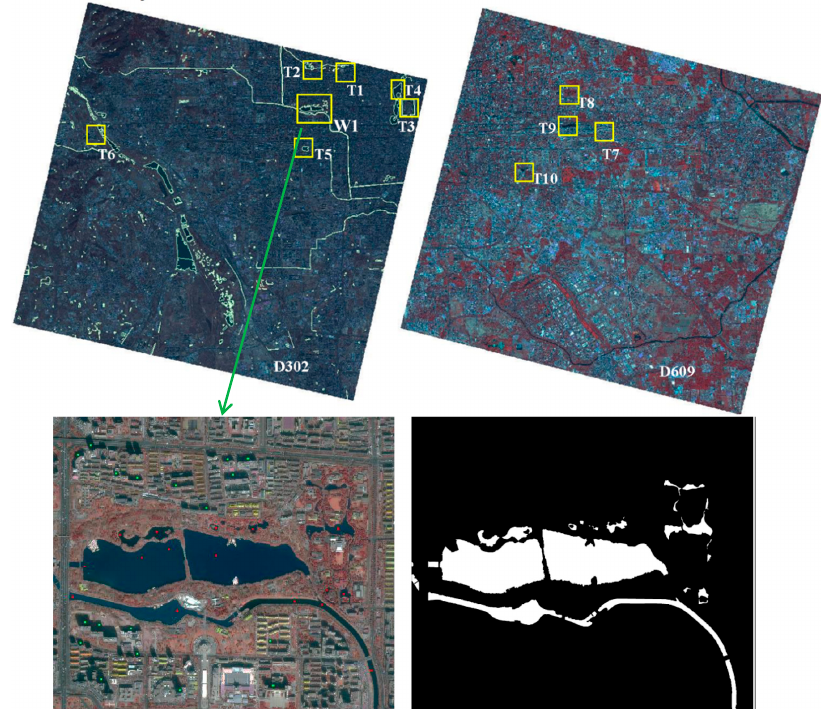
Figure 1. The two upper images are pan-sharpened GaoFen-2 images (namely D302 and D609) and the related training and test data in our experiment. W1 refers to the training subset. T1 to T10 refer to subsets for the test, and the size of each test data is 1500×1500 pixels. Water areas enclosed by light green lines in D302 indicate manually interpreted ground truths. The images are aligned based on their true geographical locations and are displayed with R (NIR)-G (R)-B (G) after being linearly stretched to [0,255]. The original spatial resolution of the image is 0.8 m. At the bottom, the W1 is specifically enlarged with its ground truth, and typical water (in red) and shadow samples (in green) selected from the W1 are displayed on the